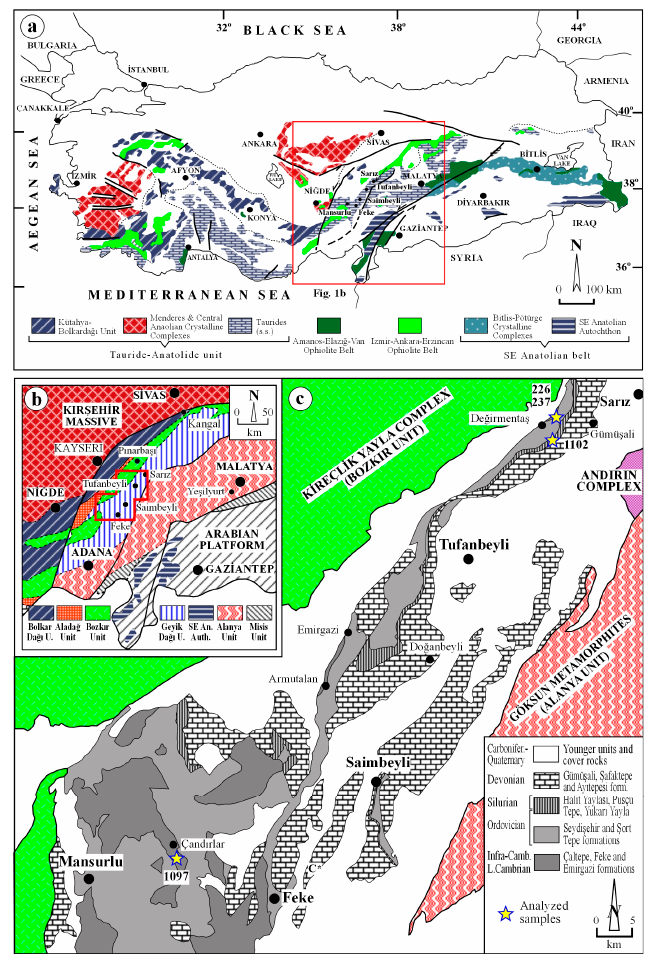
Figure 1. ( a ) Tectonic map of southern Turkey (Modified from [32]). ( b ) Tectono-stratigraphic units 1 of the Eastern Tauride belt [34]. ( c ) Geologic map of the Geyik Da˘gı Unit between Sarız and Feke (simplified from [38]) and sample